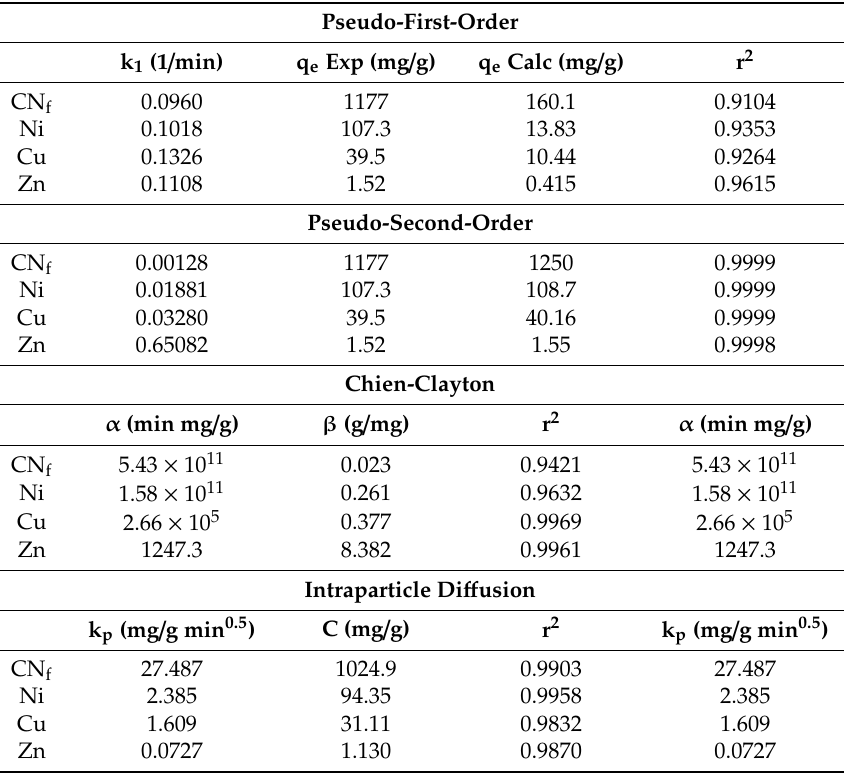
Table 4. Kinetic parameters obtained after the adjustment of experimental data to the di ff erent kinetic